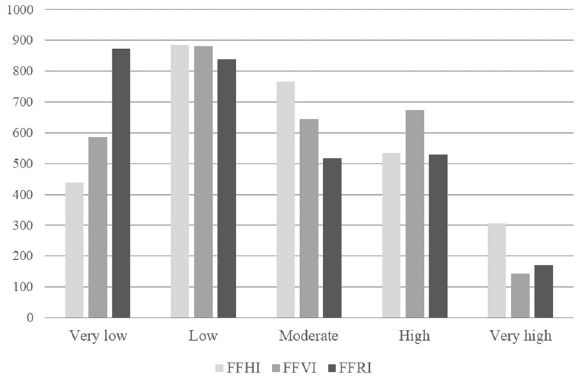
Figure 14. Distribution of municipalities in FFHI, FFVI, and FFRI classes.